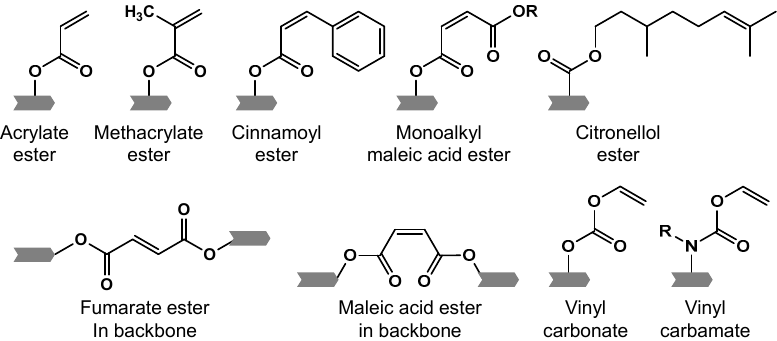
Figure 1. Selected functional groups used for chemical cross-linking of macromers by cross-polymerization. The symbol represents an oligomer segment that contains a functional group.